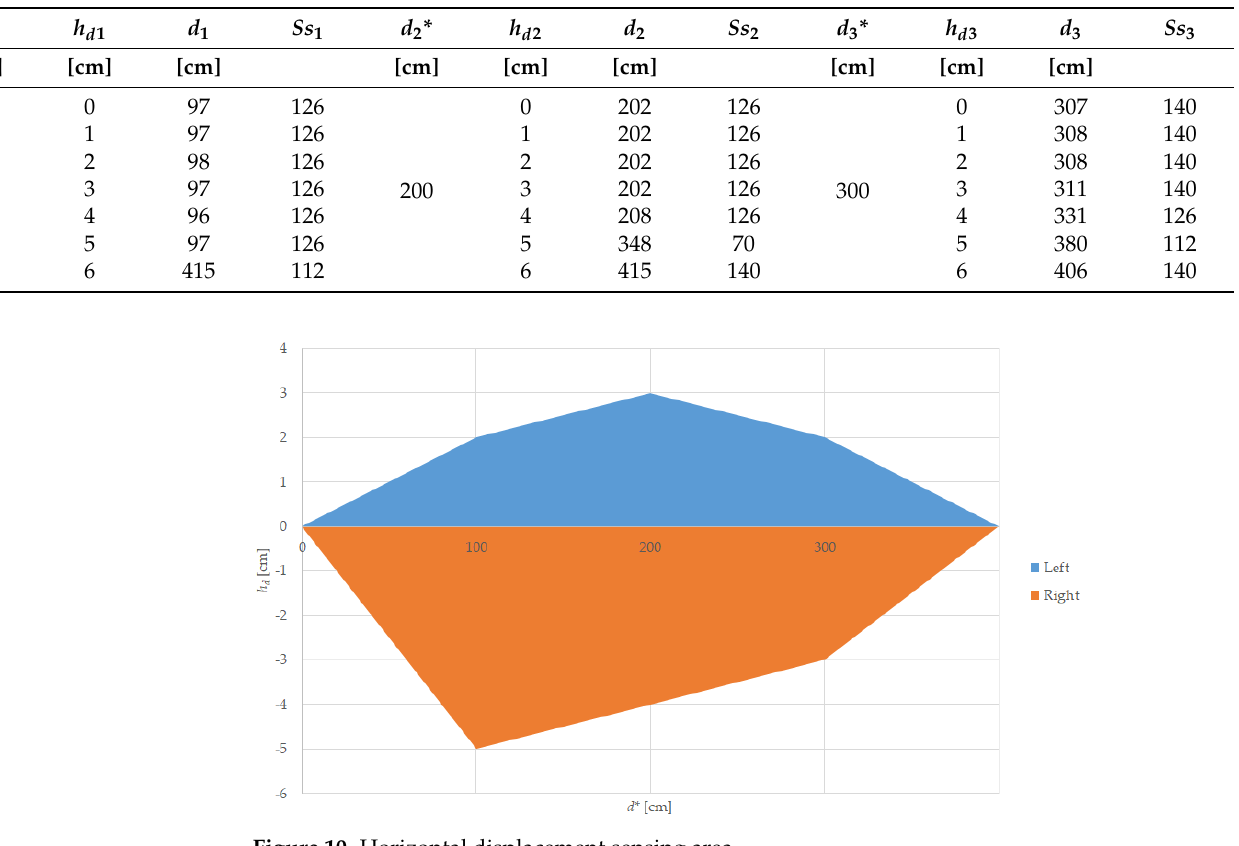
Table 4. Right horizontal displacement experimental results with tramcar target.